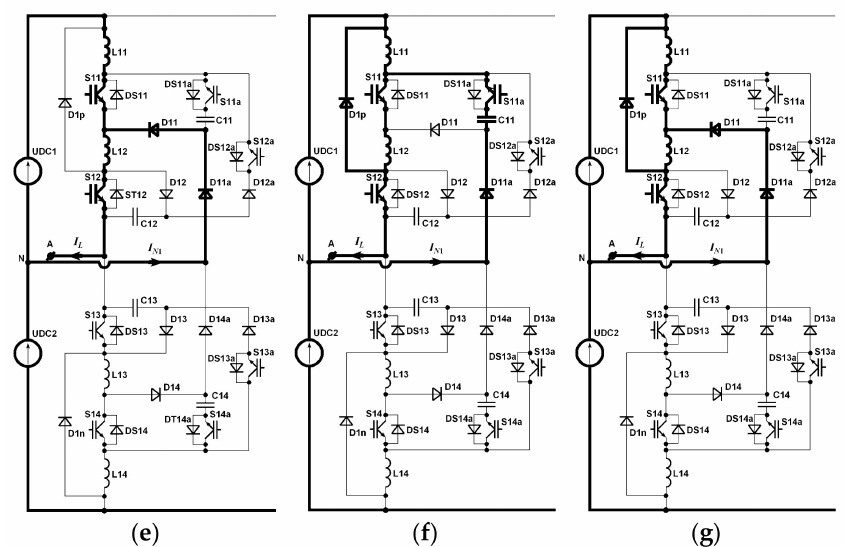
Figure 3. Operation stages when S11 is switched ON/OFF in individual time intervals: ( a ) before time t 11 ; ( b ) t 11 – t 12 ; ( c ) t 12 – t 13 ; ( d ) t 13 – t 14 ; ( e ) t 14 – t 15 ; ( f ) t 16 – t 17 ; ( g ) t 17 – t 18